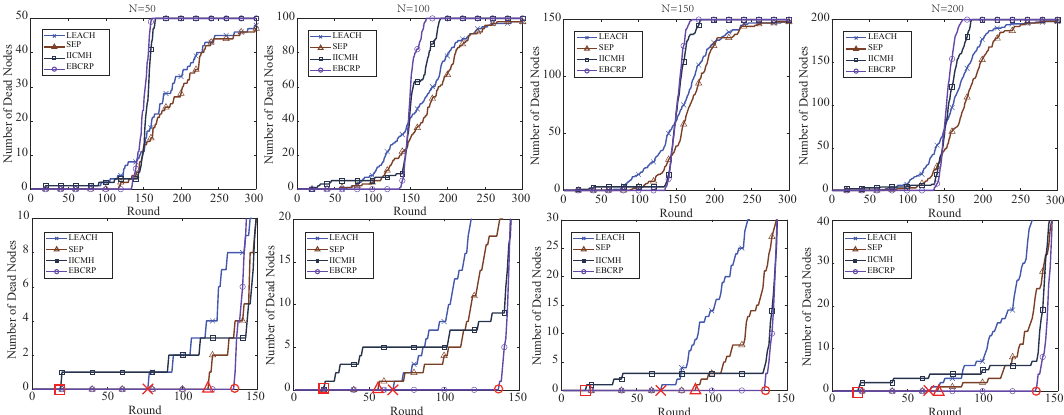
Figure 8. Number of dead nodes of different methods in different rounds, and the bottom subfigures detail the the first dead